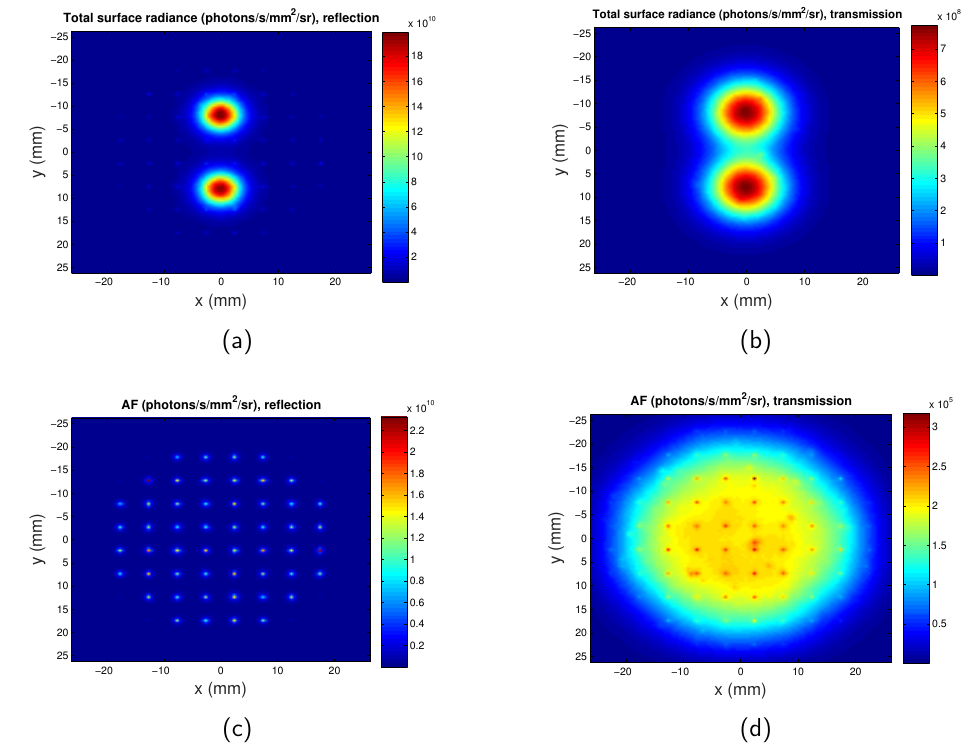
Figure 8. Maps of surface radiance considering autofluorescence at excitation wavelength of λ ex = 600nm. z = − 4mm. Separation between the two QDs regions is D = 16mm. ( a ) Total surface radiance in reflection mode; ( b ) total surface radiance in transmission mode; ( c ) surface radiance for only autofluorescence in reflection mode; and ( d ) surface radiance for only autofluorescence in transmission mode. AF: